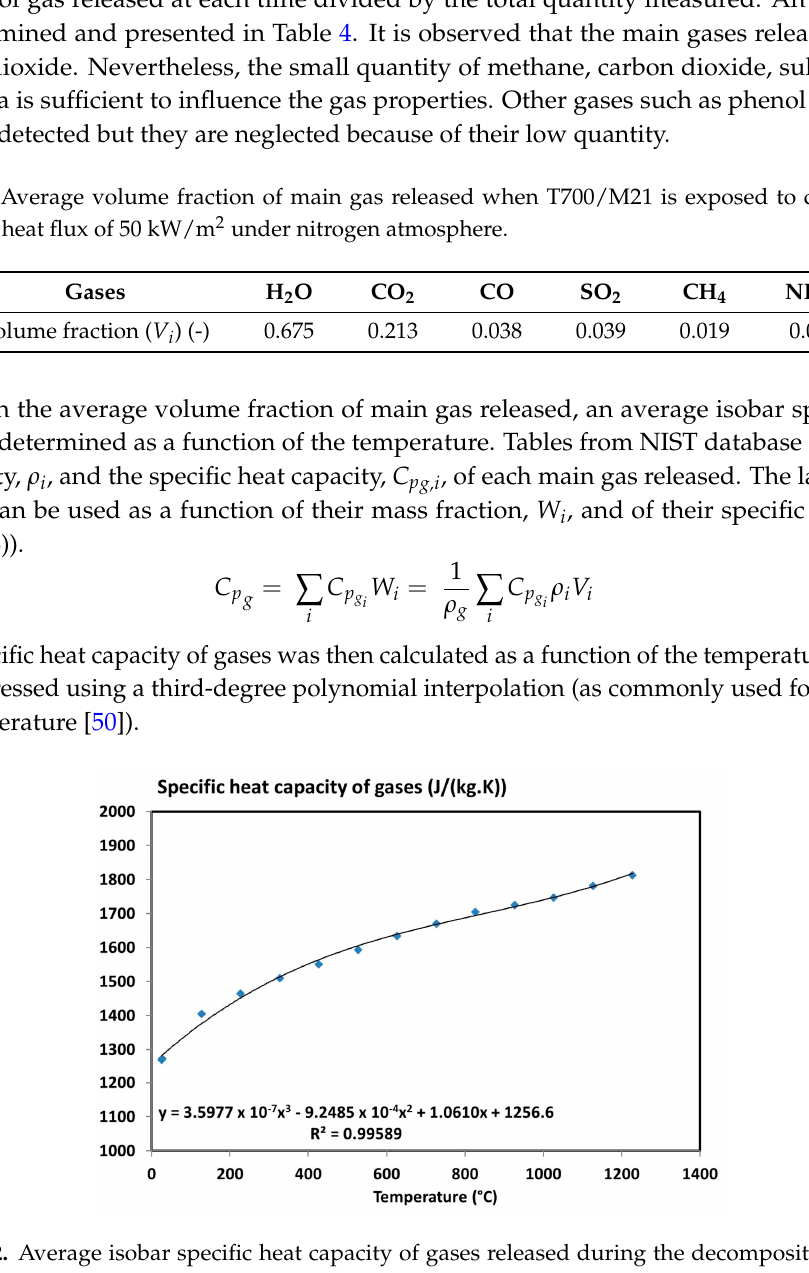
Figure 12. Average isobar specific heat capacity of gases released during the decomposition of the T700/M21 as a function of the temperature [6].